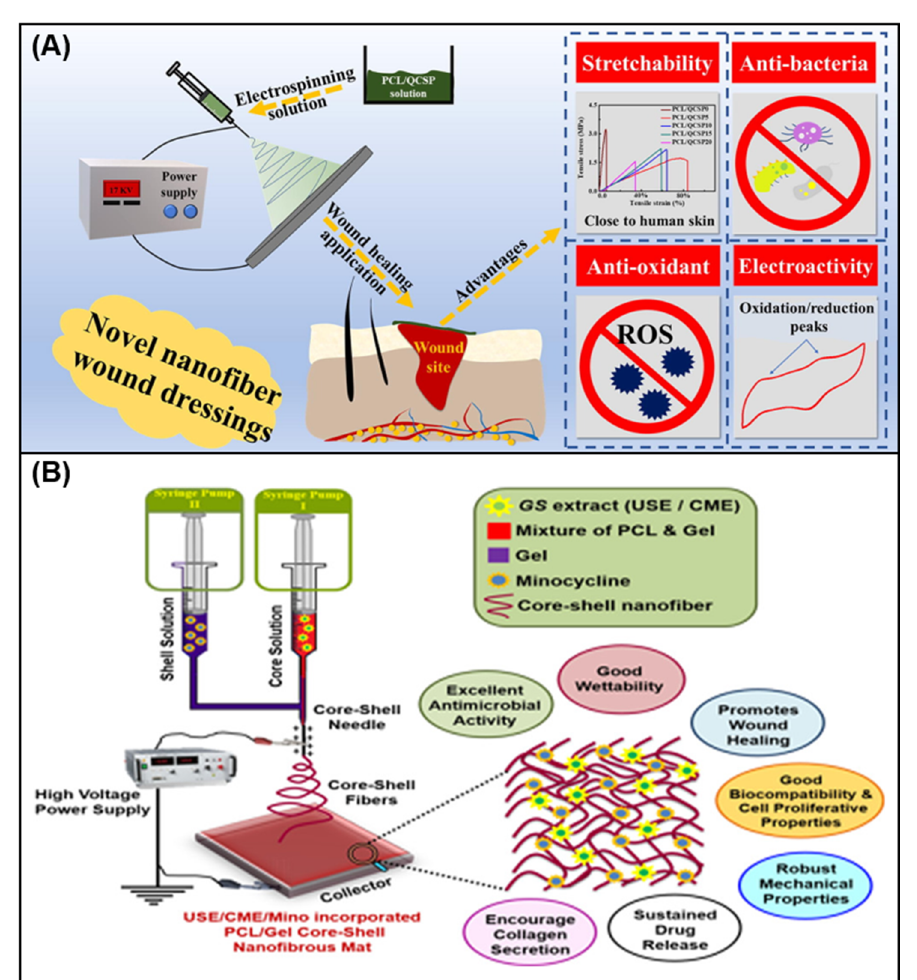
Figure 6. ( A ) Electrospinning PCL/QCSP nanofiber membrane with anti-bacteria, anti-oxidant, stretchability and electroactivity [113]; ( B ) preparation of coaxial electrospinning nanofiber mat and